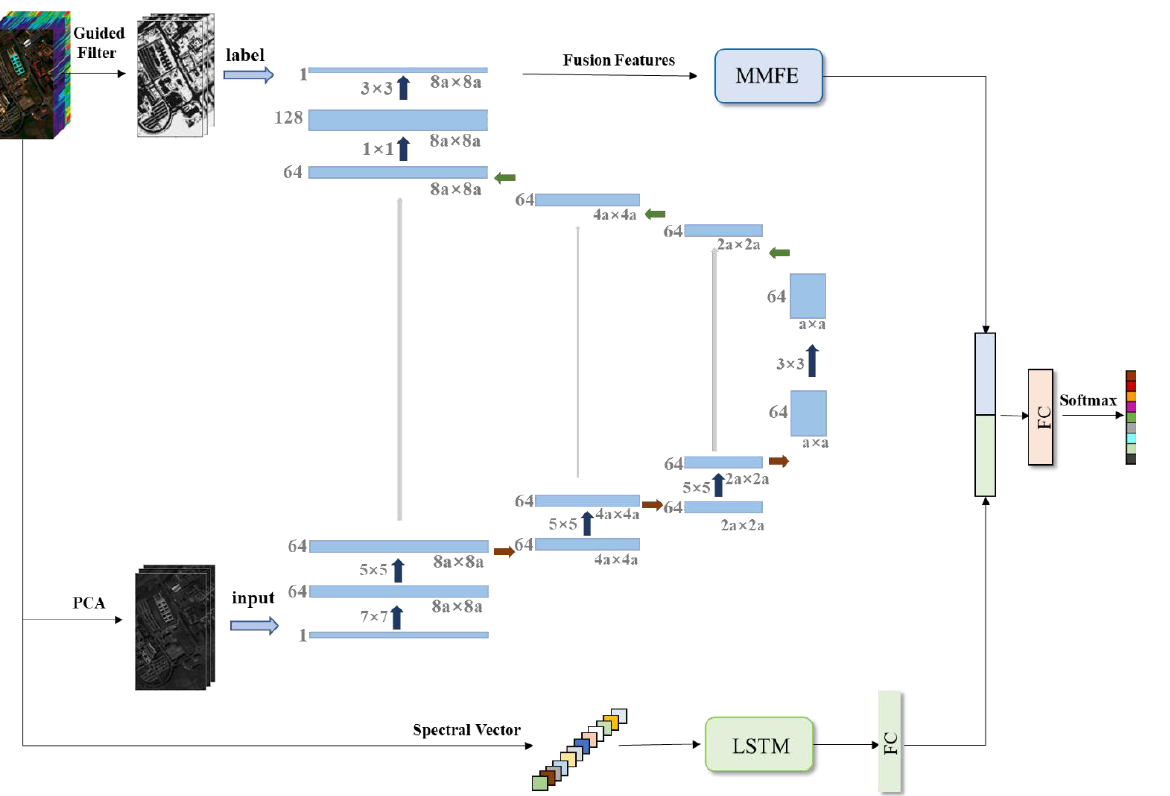
Figure 5. Spectral–spatial classification method based on deep adaptive feature fusion (SSDF) model.